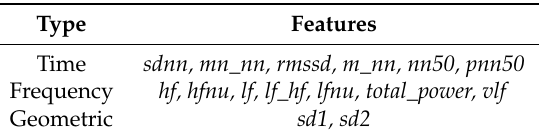
Table 2. HRV based